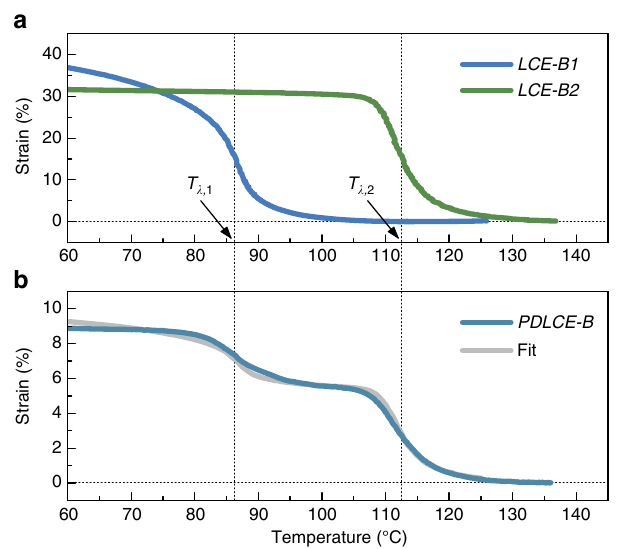
Figure 6 | Customization of thermomechanical response. ( a ) Thermomechanical, equivalently strain versus T response curves of nematic LCE-B1 and smectic A LCE-B2 used for preparation of the bimodal PDLCE composite. ( b ) Experimentally determined bimodal thermomechanical response of PDLCE-B , fitted by linear superposition model. Percentage strain 100( l ( T ) (cid:3) 1) is shown in ( a , b ). (nematic phase) below T l ,1 in the M4 -rich LCE-B1 , molecular